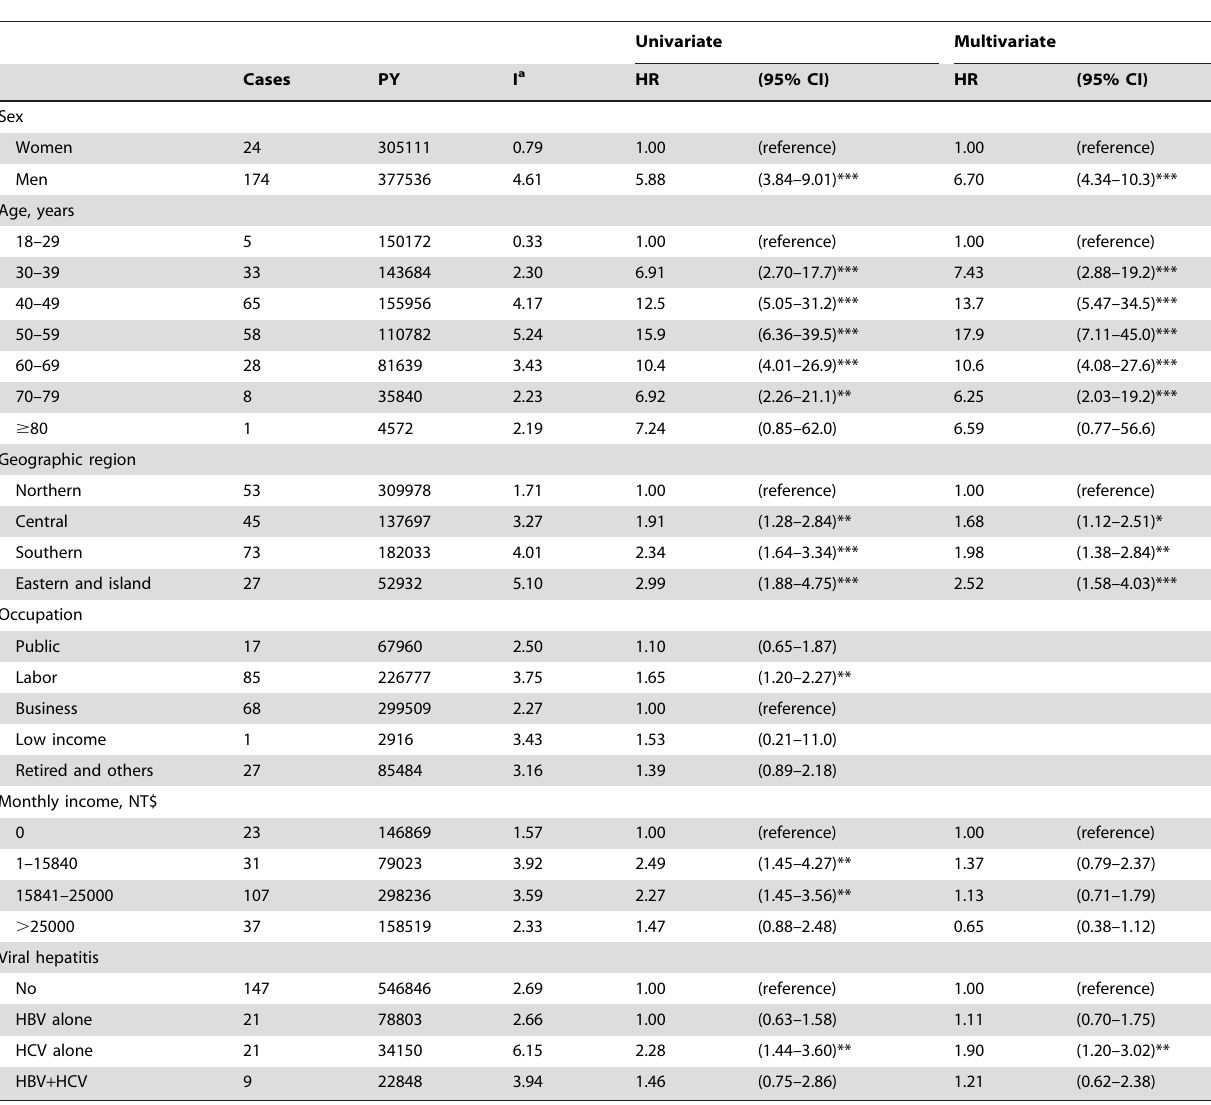
Table 2. Incidence density of oral cavity cancer for viral hepatitis and non-viral hepatitis adult cohorts identified in